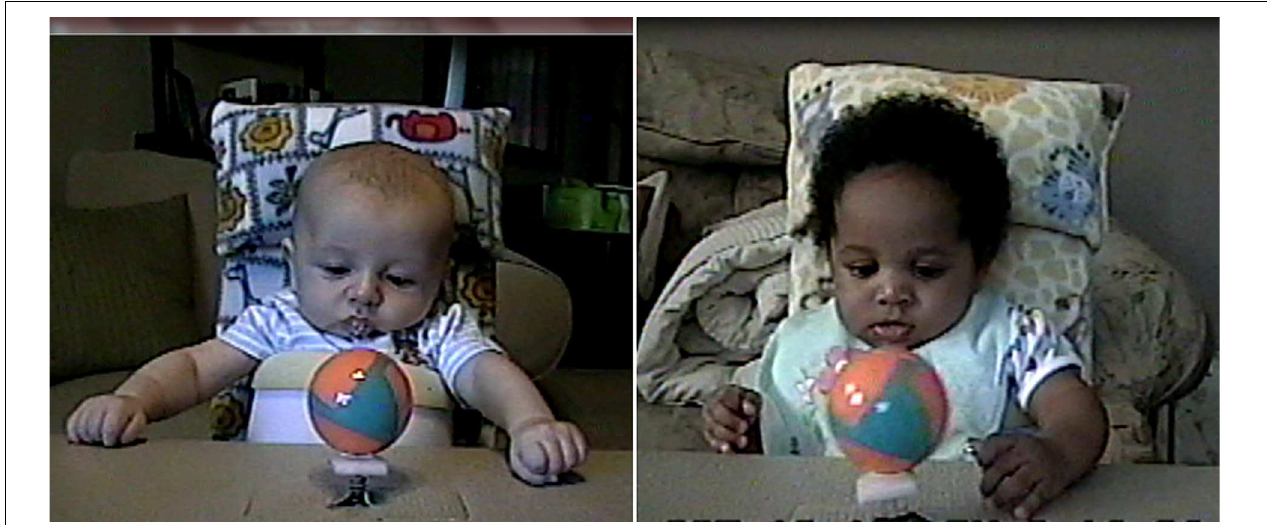
FIGURE 1 | Screenshot of gaze camera to depict the experimental setup for contingent (Left) and continuous (Right) conditions.